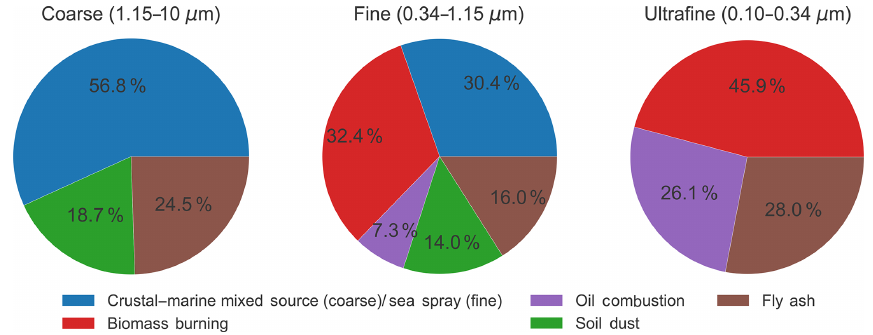
Figure 5. Contributions of factors to the total elemental PM mass. The crustal–marine mixed source (coarse mode) and sea spray (fine mode) share the same color to reflect their similar chemical compositions.